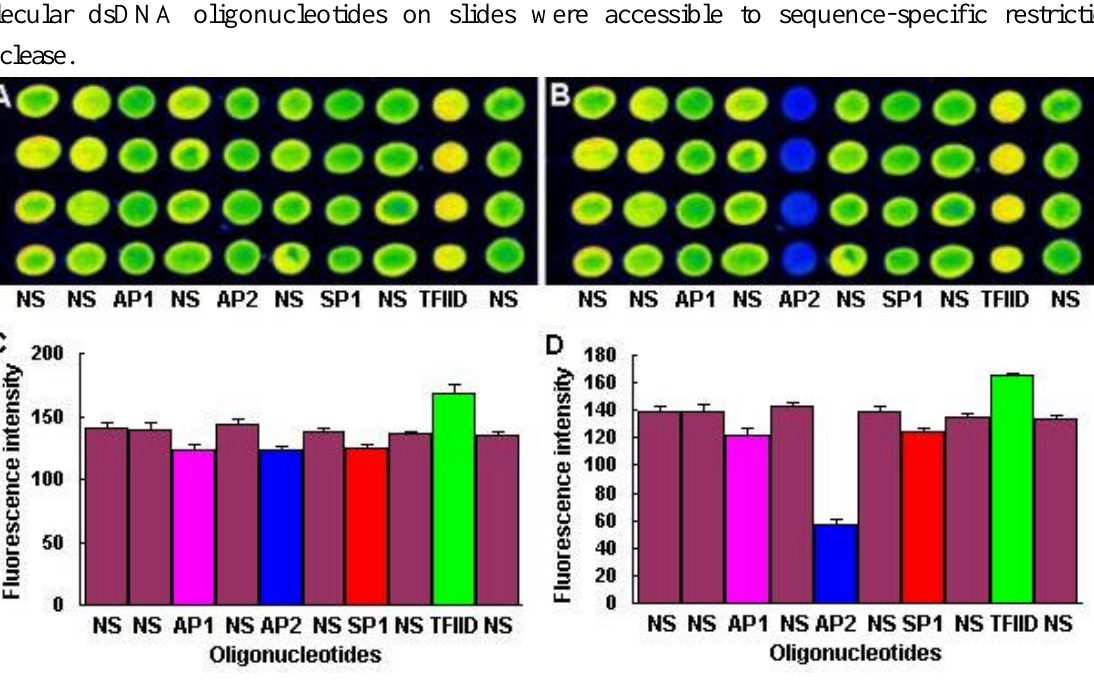
Figure 3. Fluorescence images and intensity plots of the unimolecular dsDNA microarray fabricated by Klenow extension containing Cy3-labeled dUTP before (A and C) and after (B and D) HaeIII